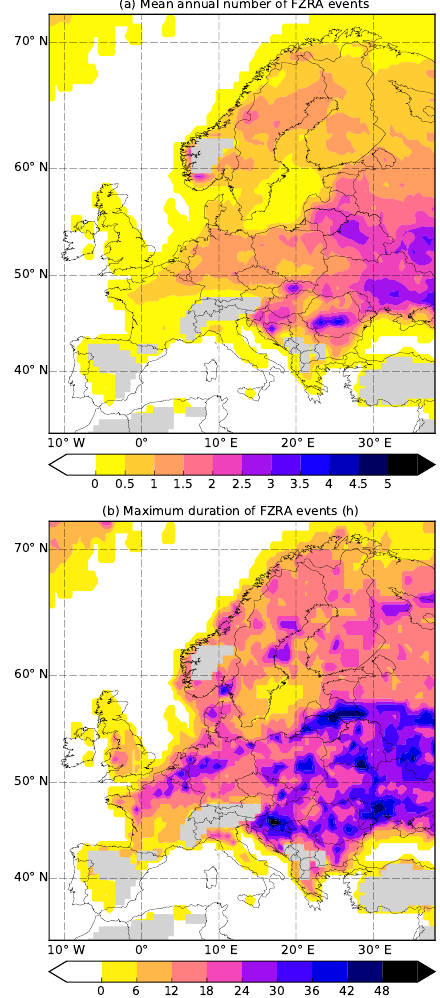
Figure 9. (a) Mean annual number of FZRA events and (b) maxi- mum duration of events in the 1979–2014 study period. FMI CLIM algorithm is applied to the ERA-Interim reanalysis data. The high- est elevations were excluded (grey) because of larger uncertainties in FZRA